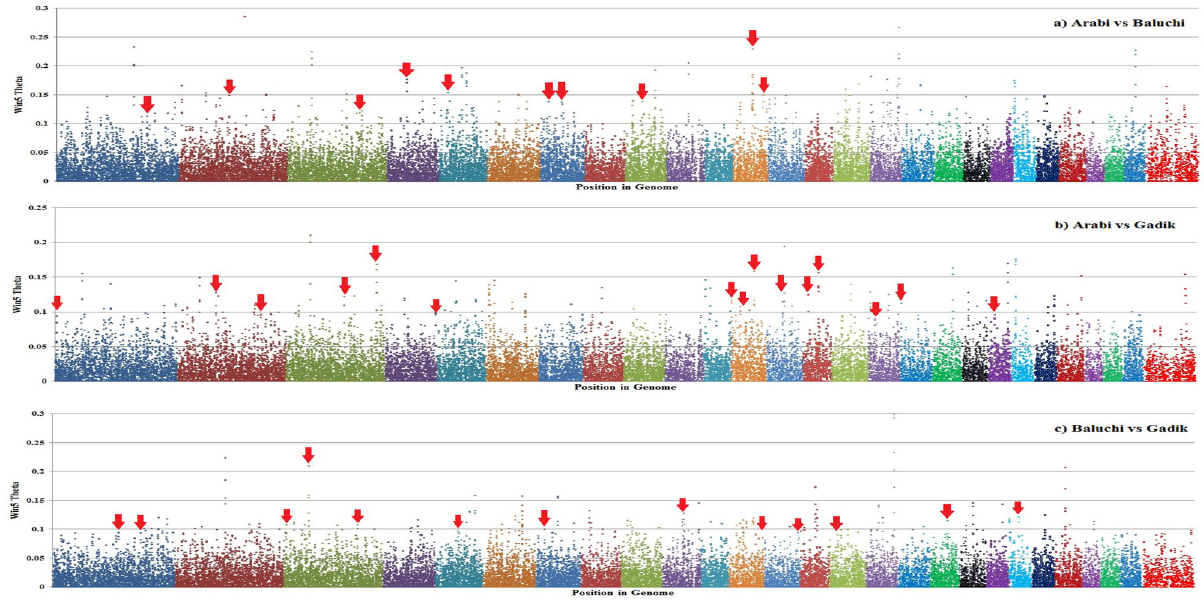
Figure 8. Distribution of selective sweep signatures for different comparisons in Afghan sheep breeds by chromosome. SNP position in the genome is shown on the X-axis and each chromosome was highlighted in different colors, and windowed F ST (Theta) is plotted on the Y-axis. The red arrows are highlighting the peaks that overlapped by CNV regions identified in our study. This figure was created using R v 4.0.2 (https:// cloud.r- proje ct.